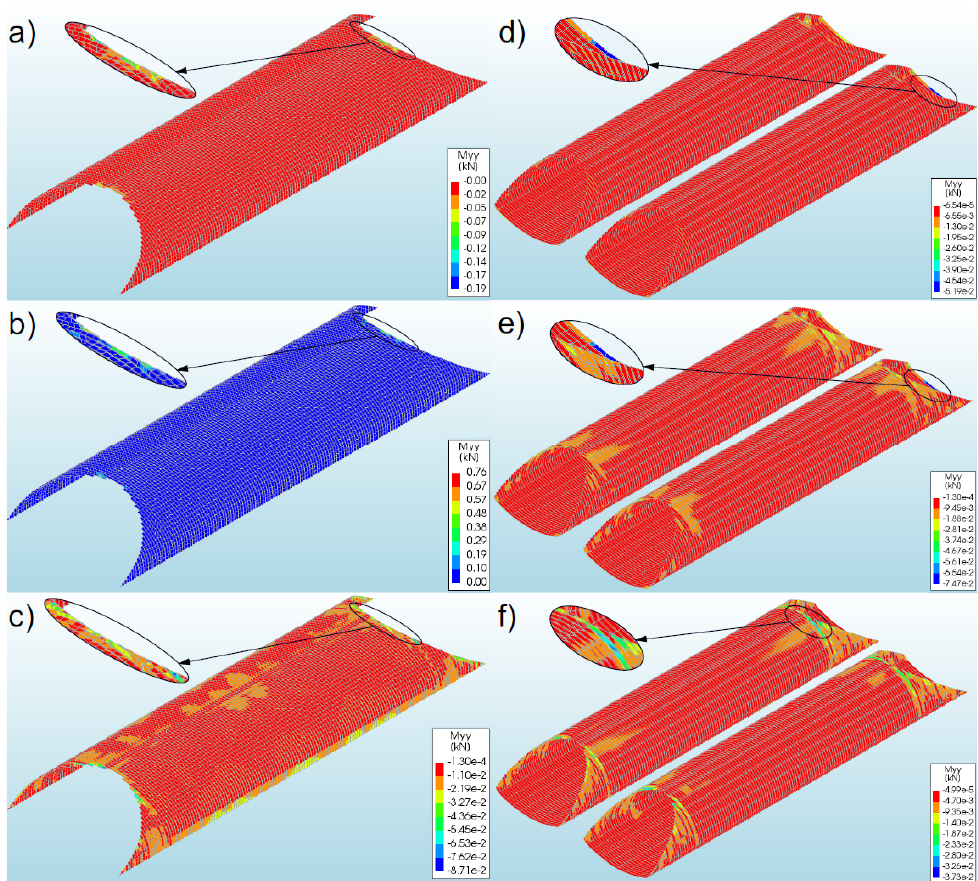
Figure 17. Distribution of maximum bending moments in the steel shell in models ( a ) 1, ( b ) 2, and ( c ) 3 (for bridge #I); and for models ( d ) 4, ( e ) 5, and ( f ) 6 (for bridge #II).